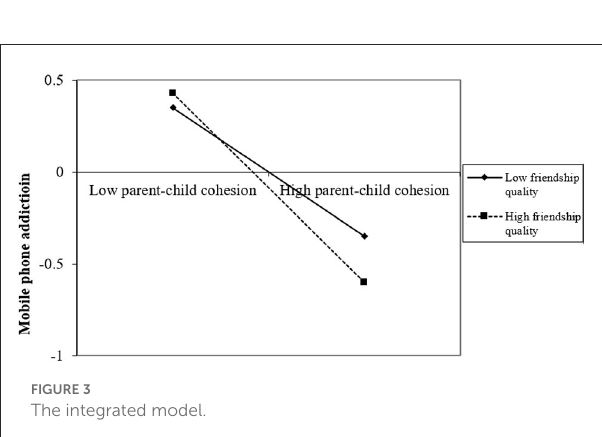
FIGURE3 The integrated